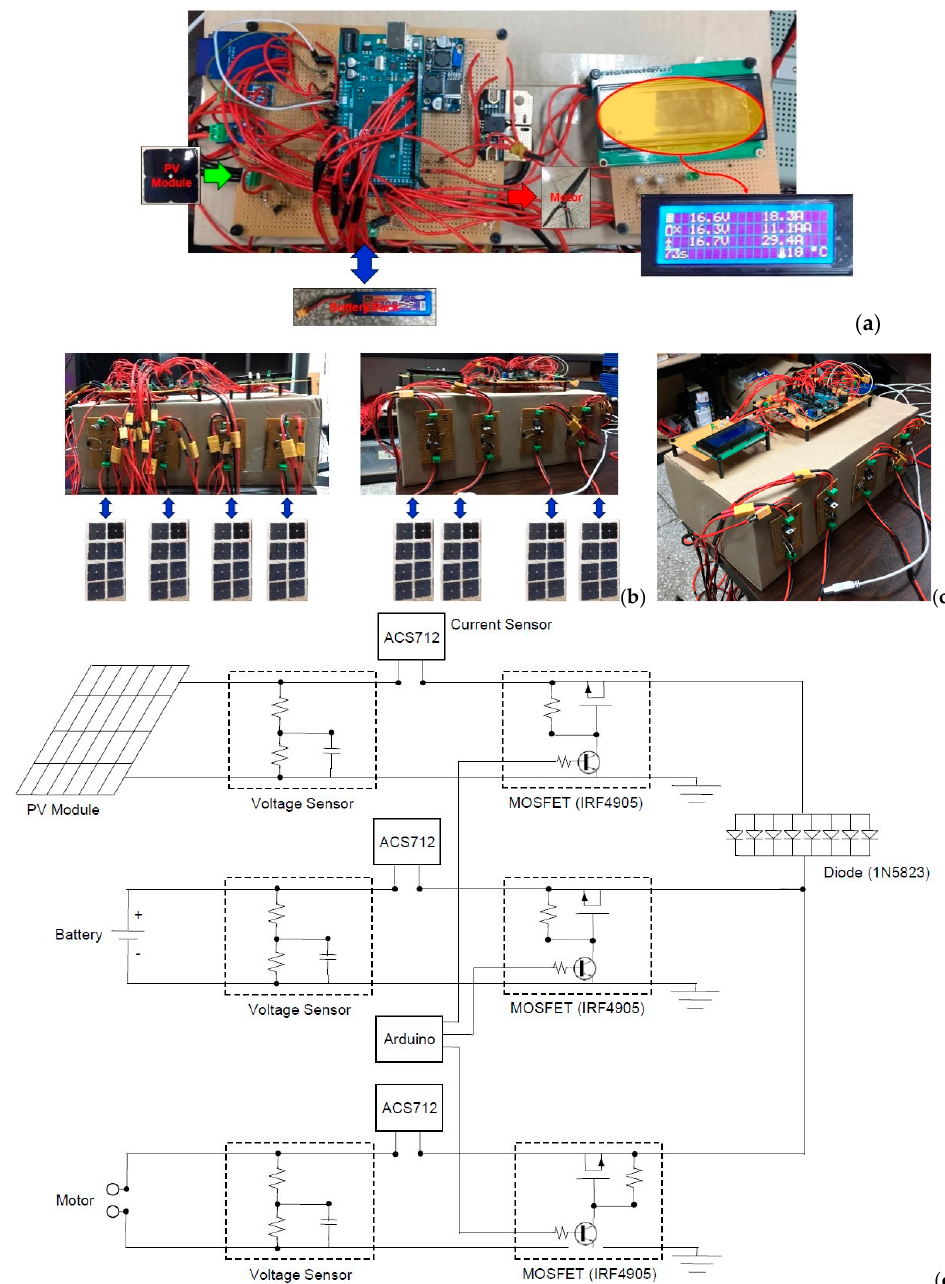
Figure 5. Hardware of the PPMS: ( a ) top view, ( b ) side view, ( c ) isometric view, and ( d ) schematic.